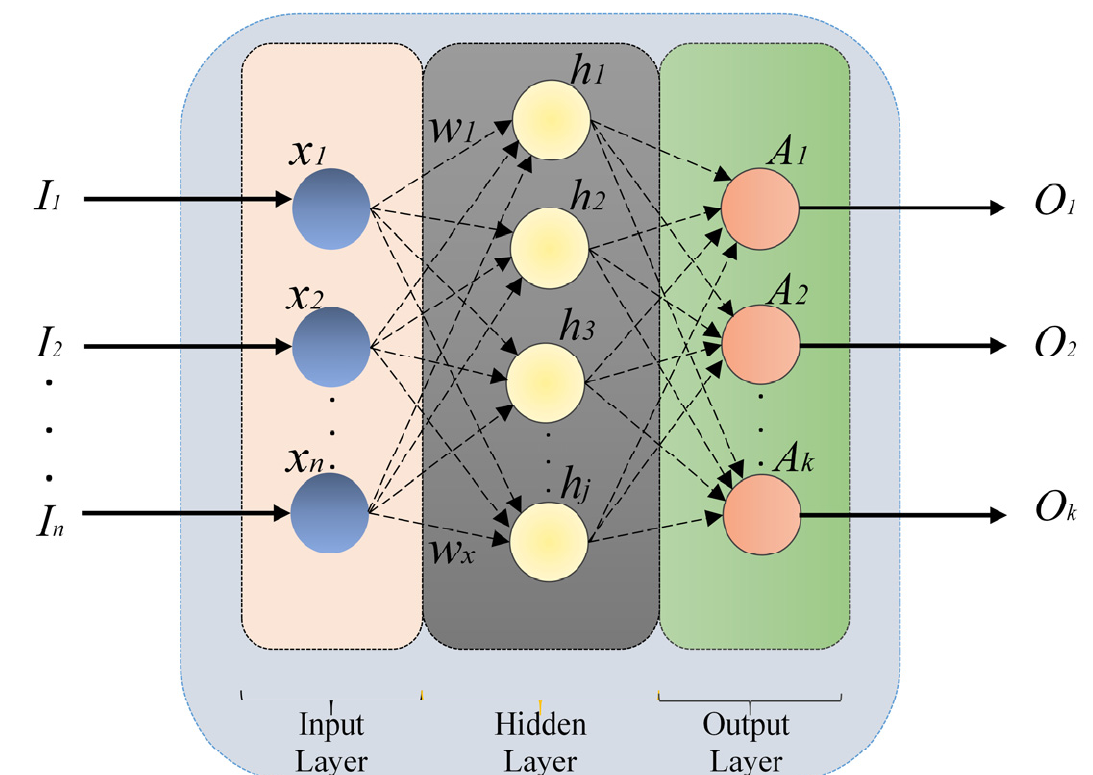
Figure 5. Typical Artificial Neural Network scheme.